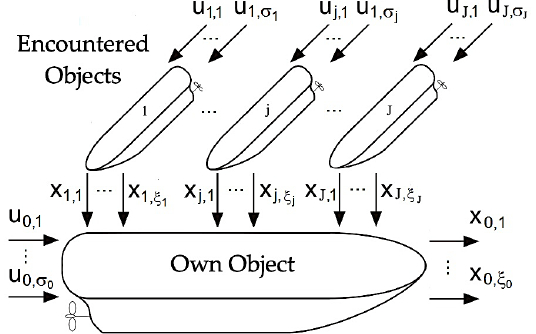
Figure 3. Interaction of the movement of own object and multiple passing objects: u 0 , x 0 — control and state of the own object; and u j , x j — control and state of the j-th object.